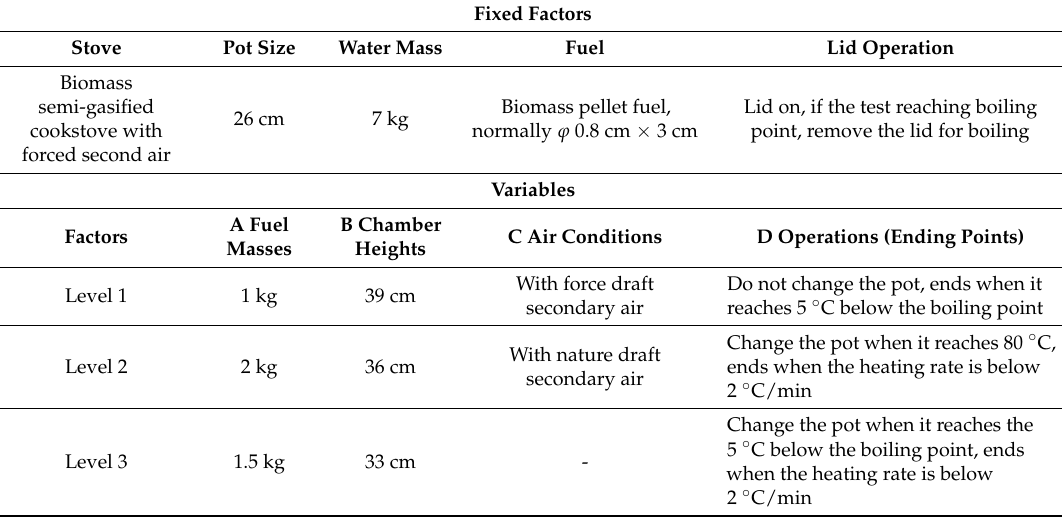
Table 2. The factors of the experiments